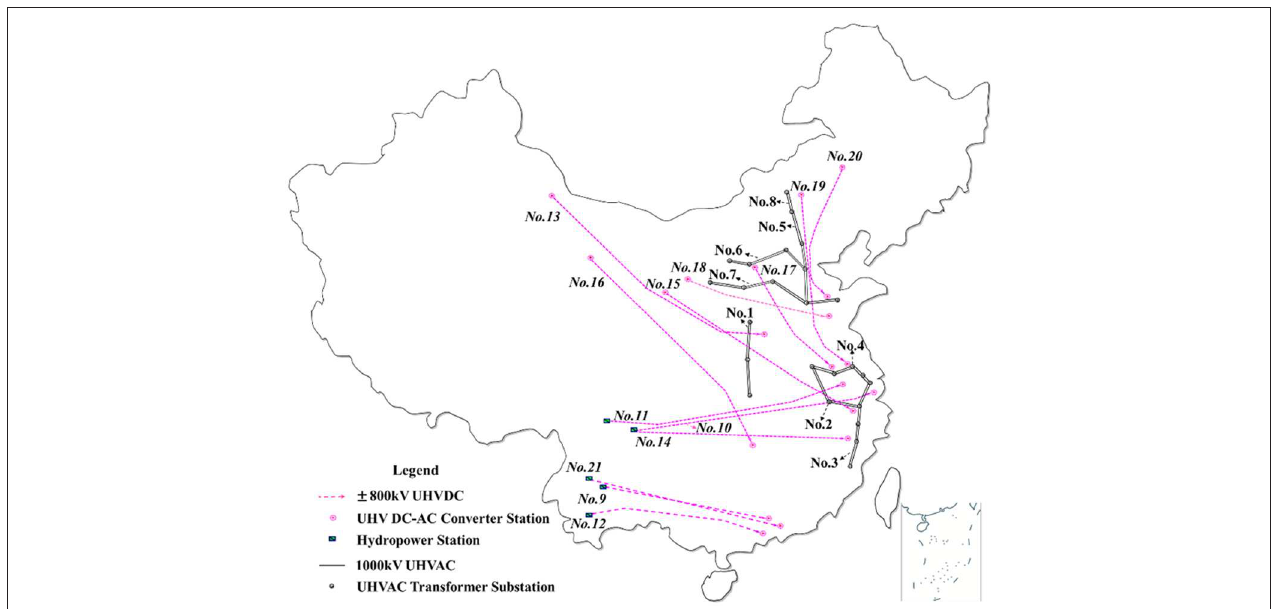
FIGURE 3 | Distribution map of the completed eight ultra-high-voltage alternative current (UHVAC) and 13 ultra-high-voltage direct current (UHVDC) transmission lines (Shu and Chen, 2018).